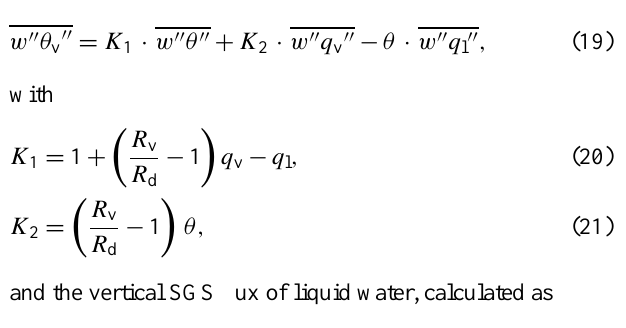
Figure 2. The Arakawa staggered C-grid. The indices i , j and k refer to grid points in the x , y and z directions, respectively. Scalar quantities ϕ are defined at the center of the grid volume, whereas velocities are defined at the edges of the grid